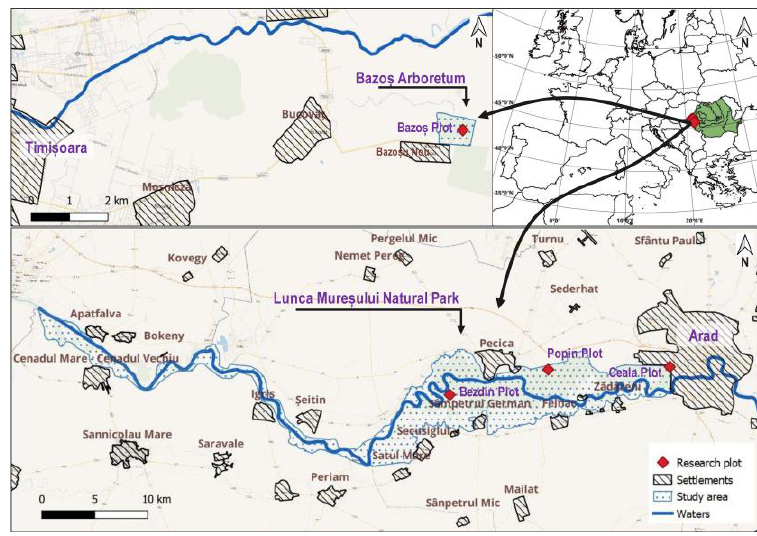
Figure 1. Research area location.